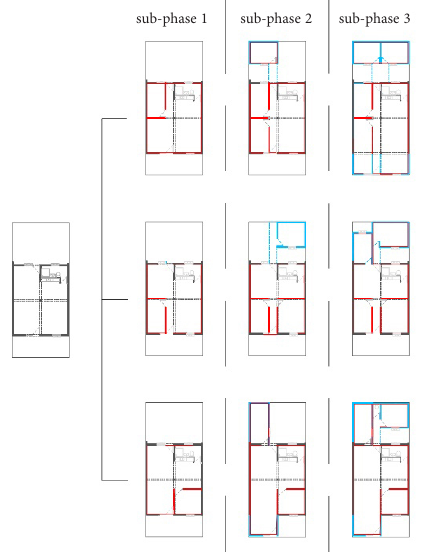
Figure 7. The design template of Las Higueras, customisation within frame of delivered houses (red); extensions of houses (blue) (source: the